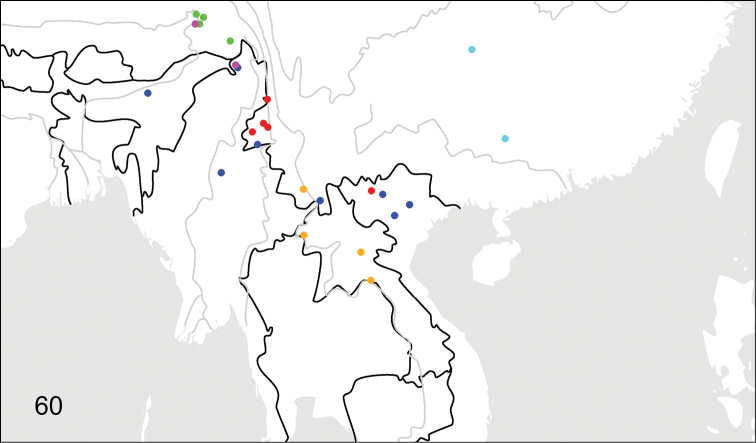
Distribution map for P.
obtusipennis Fedorenko (red); P.
obscuratus sp. n. (cyan); P.
amplus Andrewes (blue); P.
gibbosus sp. n. (magenta); P.
elegans sp. n. (green); P.
dux Andrewes (orange).